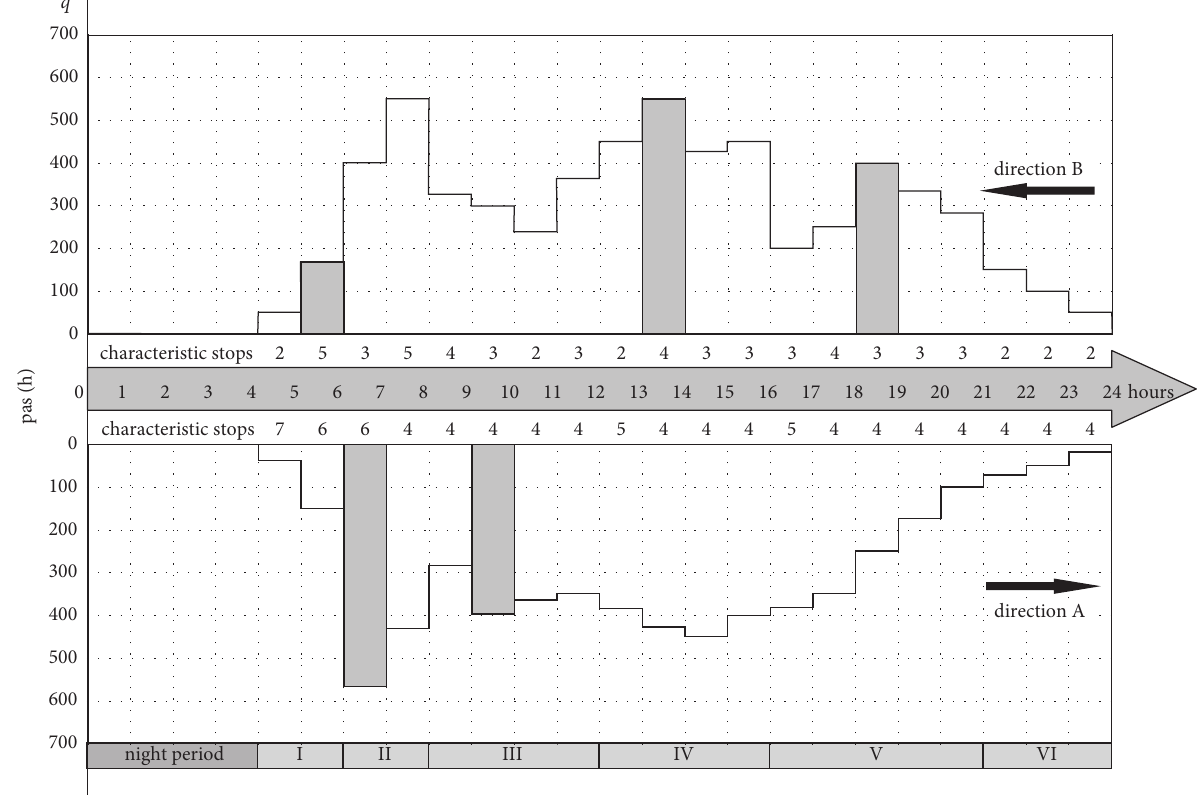
Figure 11: Typical periods of public transport vehicles operating during the day [46].